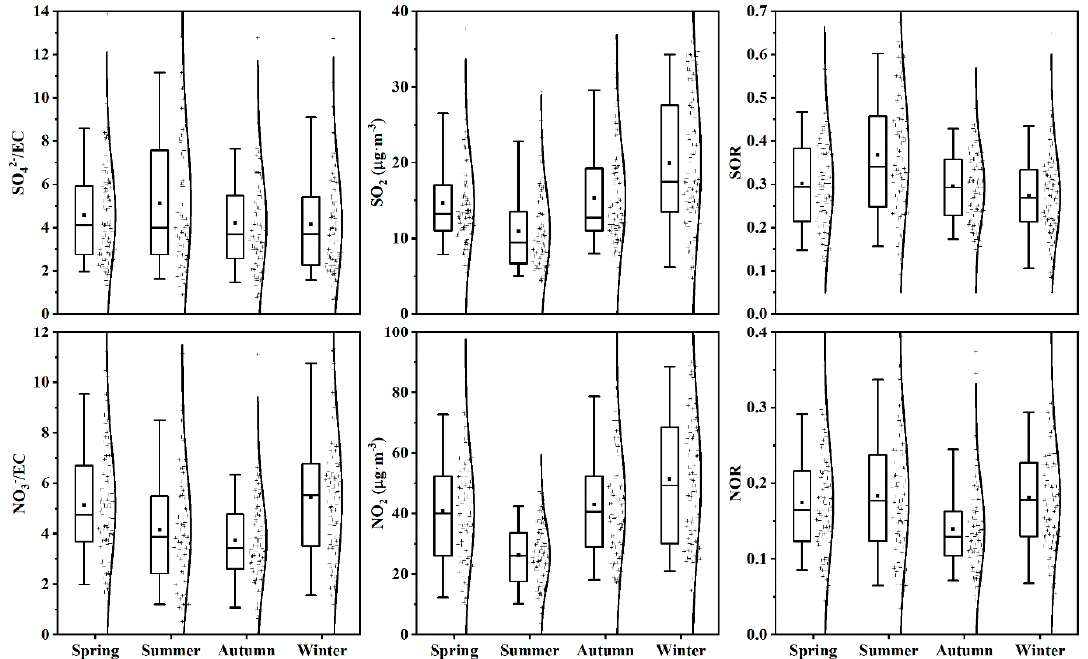
Figure 4. Seasonal variation of SO 42 − /EC, NO 3 − /EC, SO 2 , NO 2 , SOR and NOR. In the plots, the box-and-whiskers indicate the 95th, 75th, 50th (median), 25th and 5th percentiles, respectively.